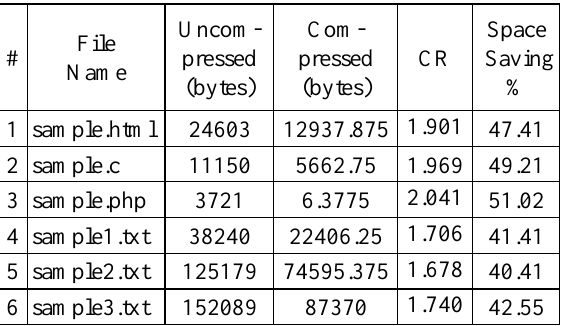
Table 5. Traditional GZIP for Storage data